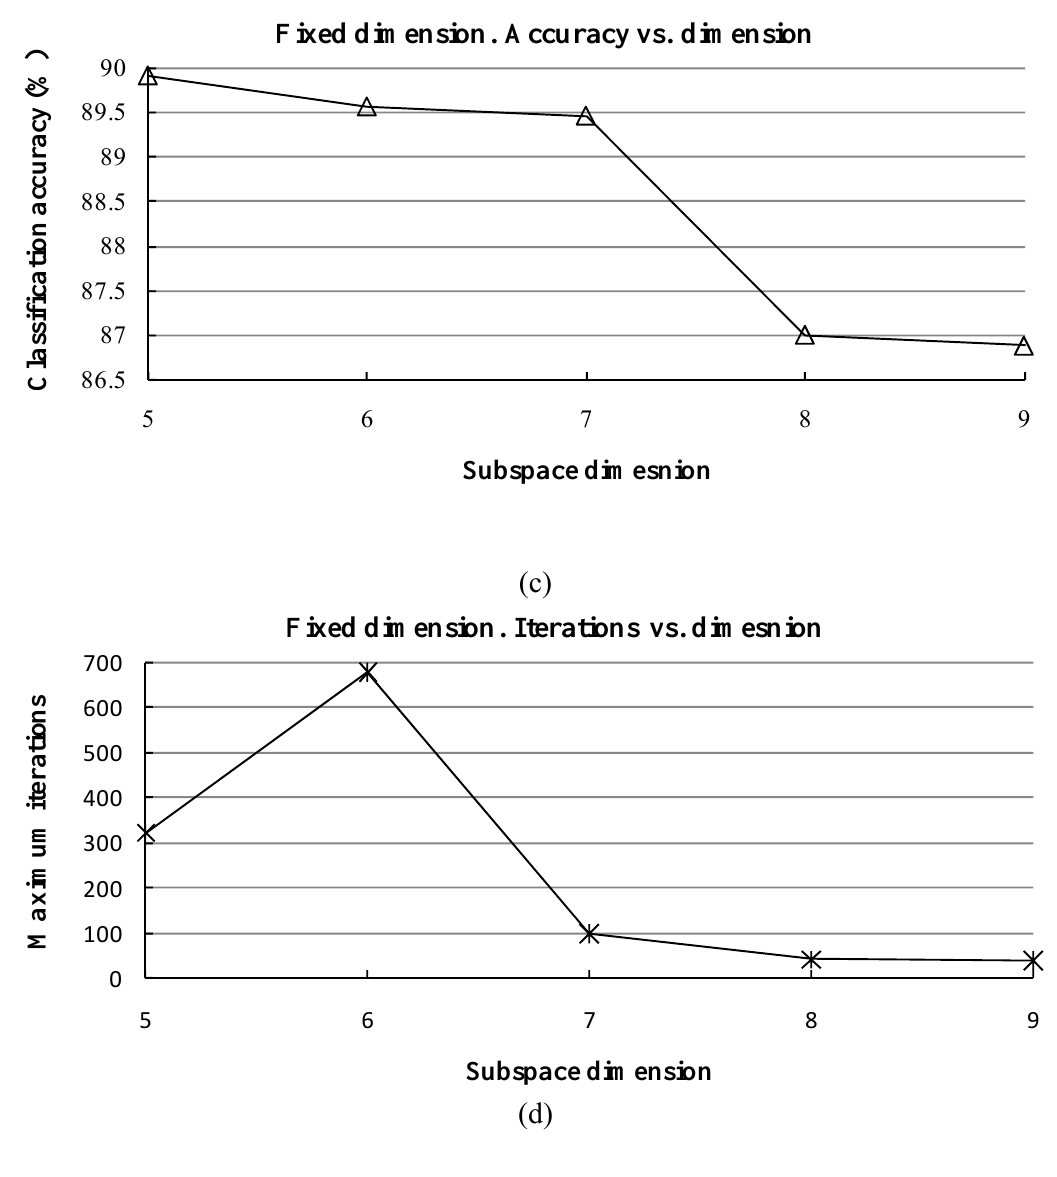
Figure 1. Cont. Fixed dimension. Accuracy vs. dimension